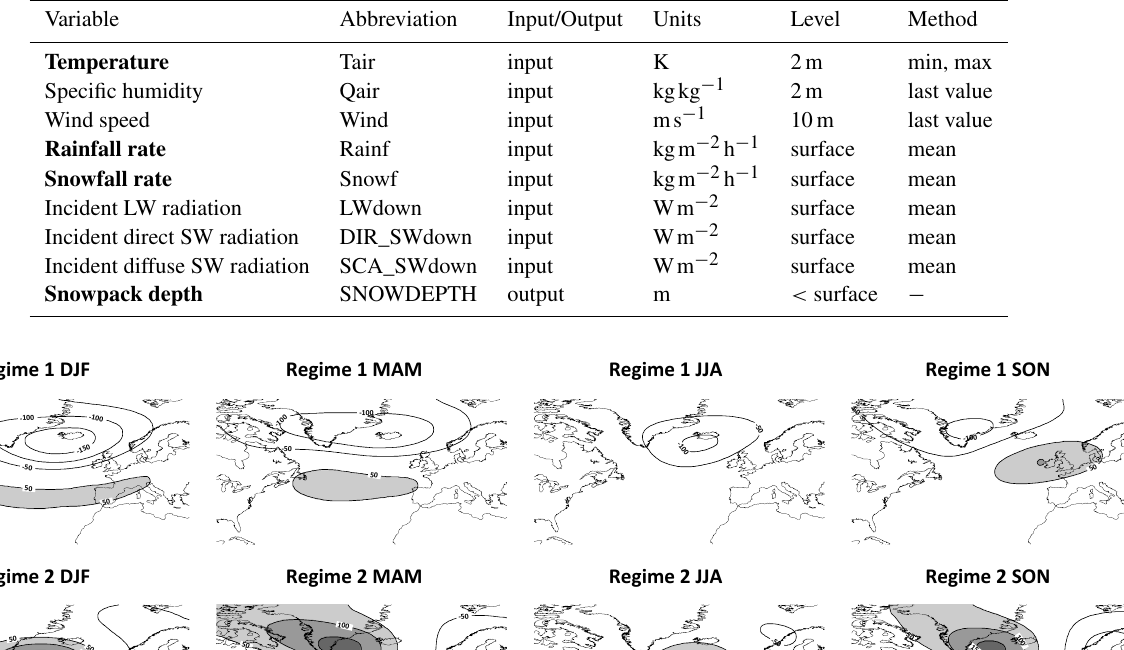
Table 1. Variables considered in this study. Variable name, abbreviation, input or output of Crocus, units, level and method of aggregation (of the observational dataset from hourly to daily) and disaggregation (RCM-adjusted data from daily to hourly). Variables used for the evaluation of the ADAMONT method are highlighted in bold characters. SW is shortwave and LW is longwave.